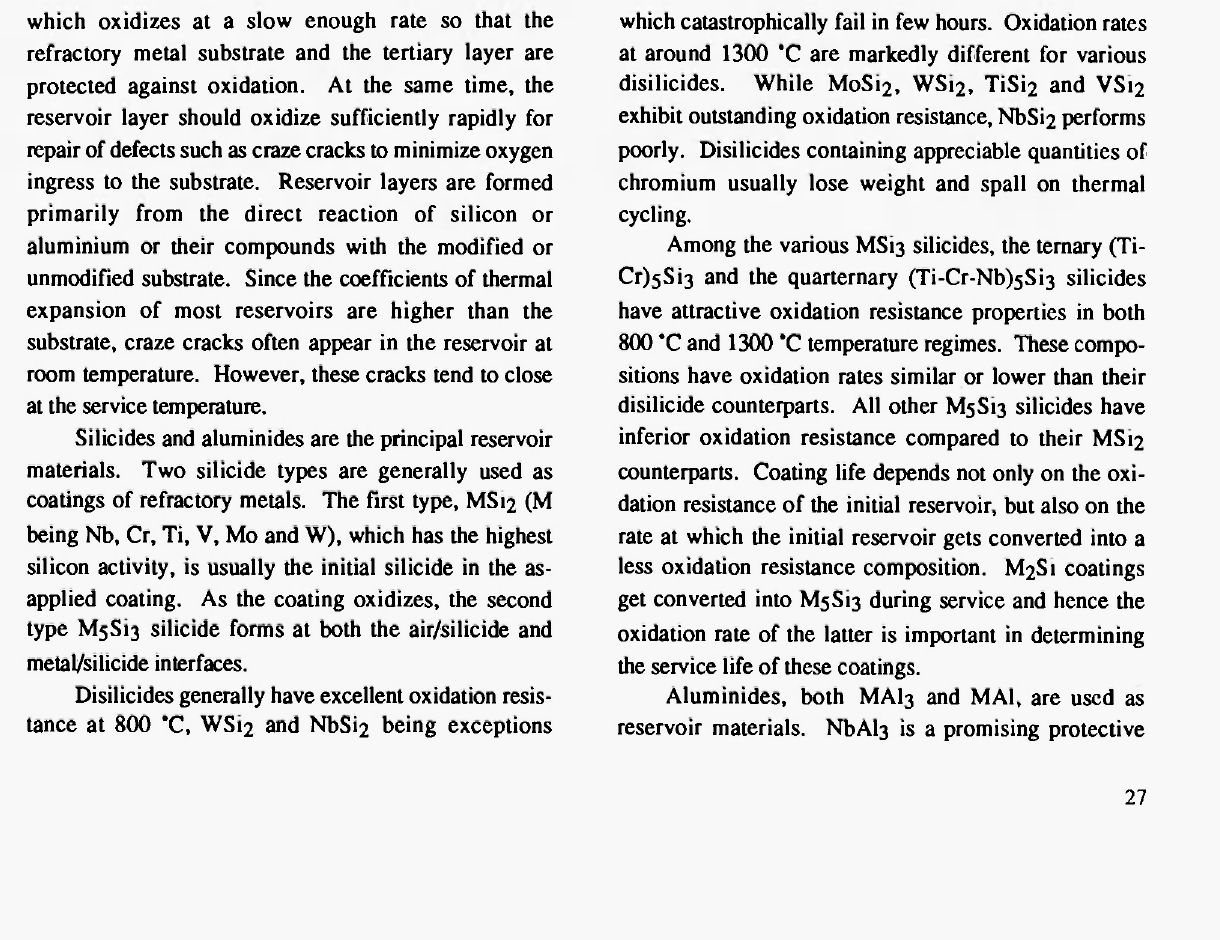
Fig. 18: A schematic description of the protective coating on refractory